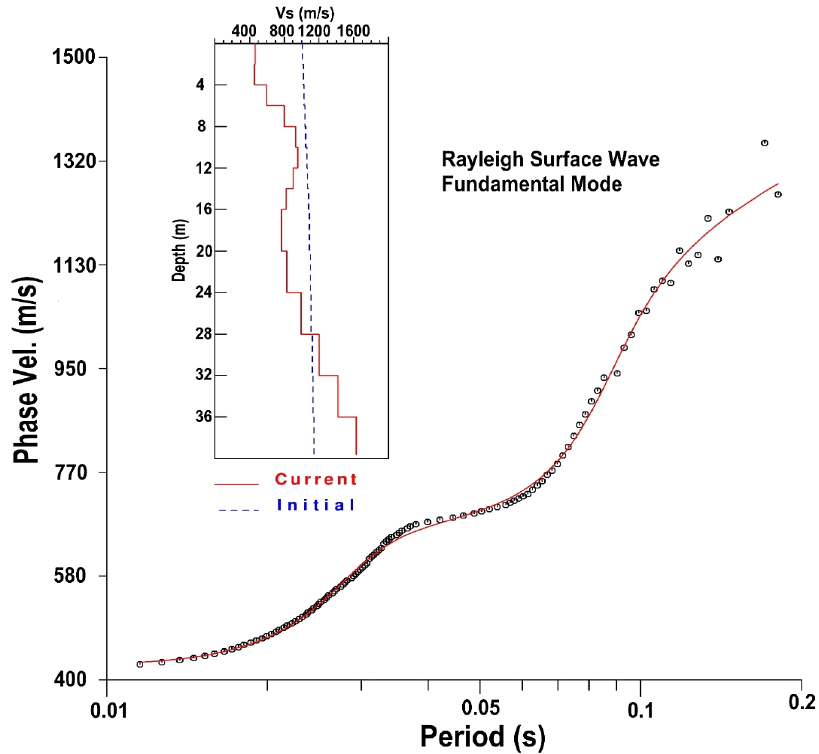
Figure 7. 1-D inversion result for the phase velocity curve in Figure 6 is shown. 𝑽𝒔 stands for the shear-wave velocity (m/s). The horizontal axis shows the period